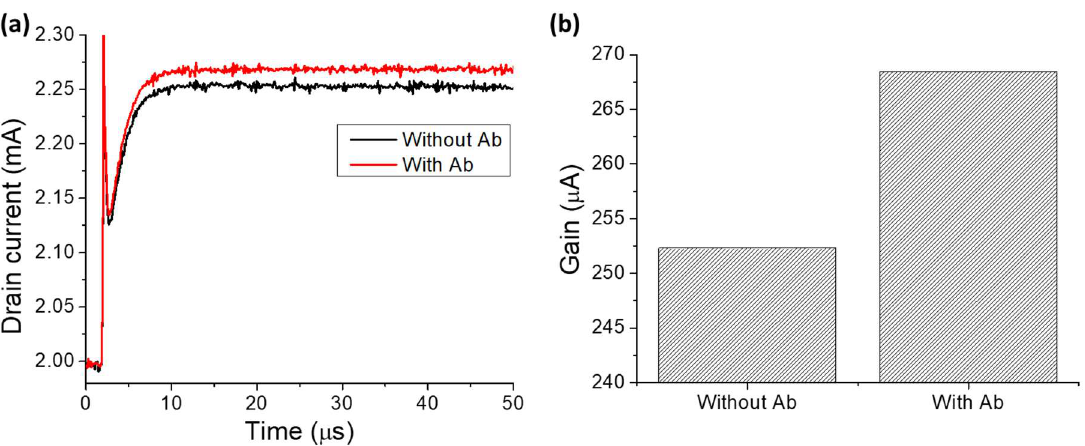
Figure 3. ( a ) Drain current versus time before and after surface functionalization. ( b ) Gain response before and after surface functionalization.